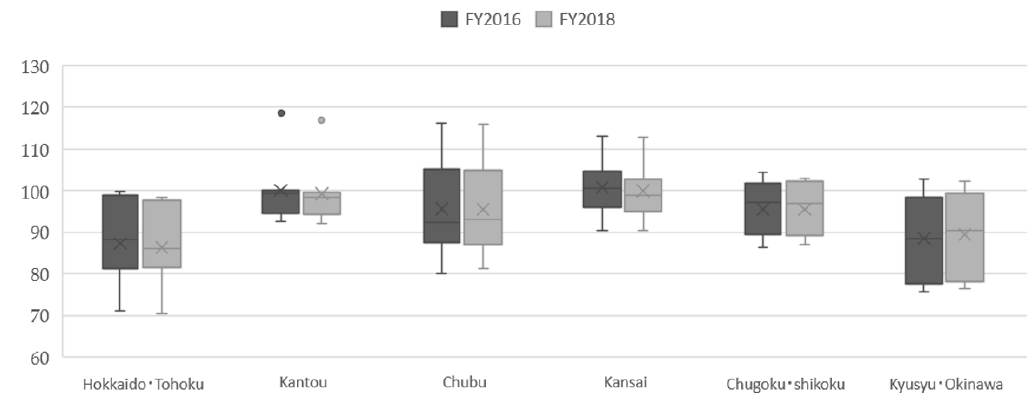
Figure 2. The Standardized Claim Data Ratios (SCRs) of total dental receipts by administrative regions in Japan, FY 2016 and 2018.